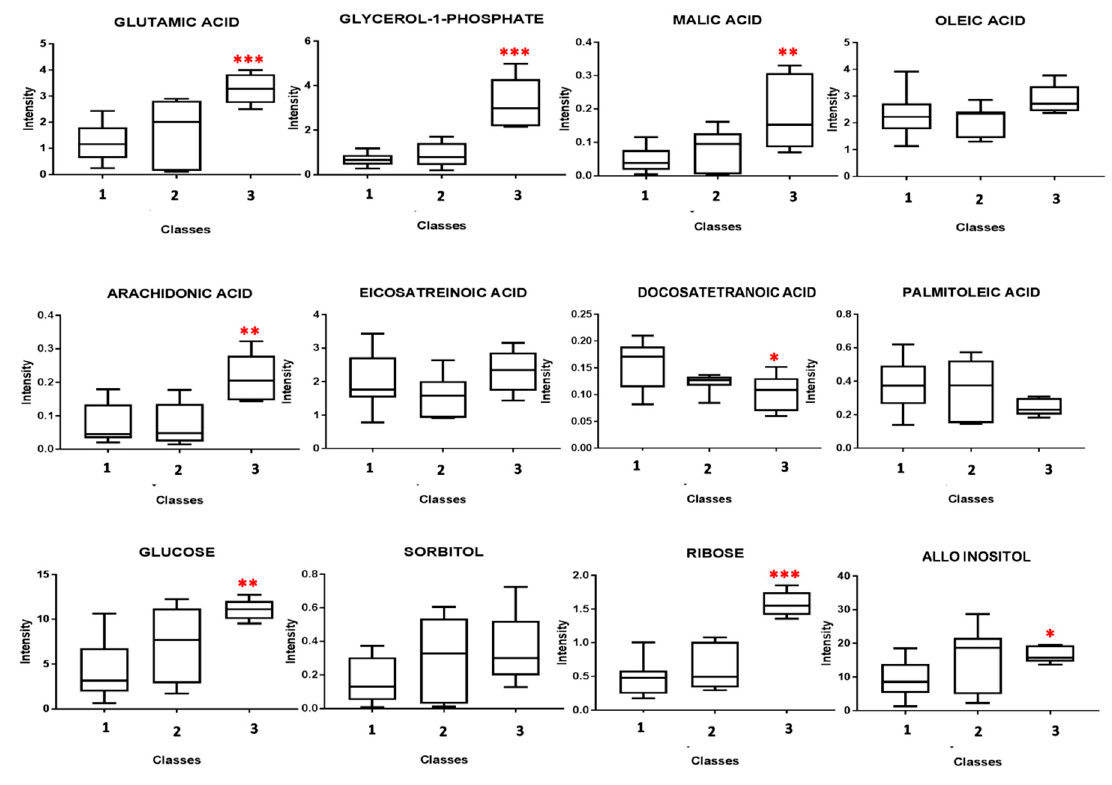
Figure 2. Box plots of the most altered metabolites resulting from the comparison between classes 1, 2, and 3. The average concentrations of the indicated metabolites underwent the Mann–Whitney U test. (* indicates a p -value < 0.05, ** indicates a p -value < 0.001, *** indicates a p -value < 0.0001).